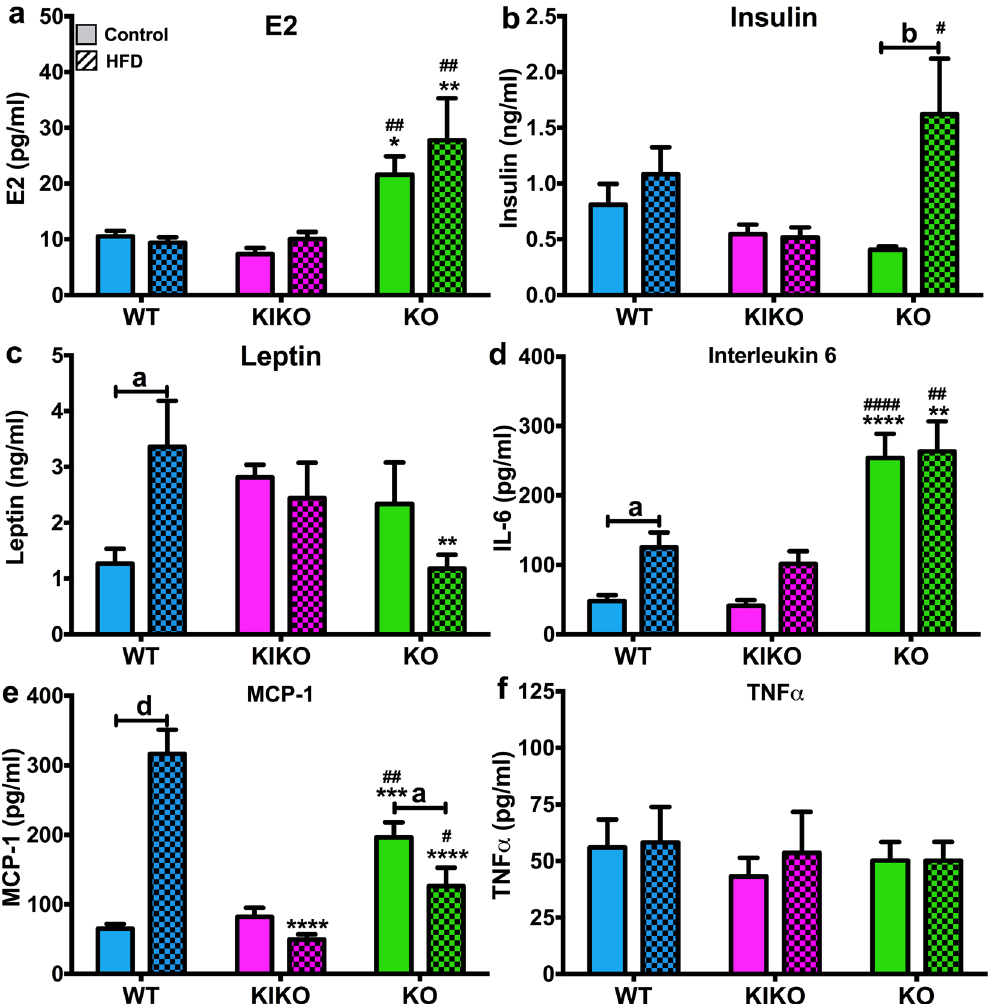
Figure 5. Peripheral peptide hormones and inflammatory cytokines from all genotypes after 20 weeks of adult chow diet. ( a ) Plasma levels of 17 β -estradiol (pg/ml). ( b ) Plasma levels of insulin (ng/ml). ( c ) Plasma levels of leptin (ng/ml). ( d ) Plasma levels of IL-6 (pg/ml). ( e ) Plasma levels of MCP-1 (pg/ml). ( f ) Plasma levels of TNF α (pg/ml). Data were analyzed by a two-way ANOVA with post-hoc Newman-Keuls test. See Fig. 1 for information on treatment categories, sample sizes, and statistical comparisons ( a/ * /# = P < 0.05; b/ ** /## = P < 0.01; c/ *** /### = P < 0.001; d/ **** /#### = P <